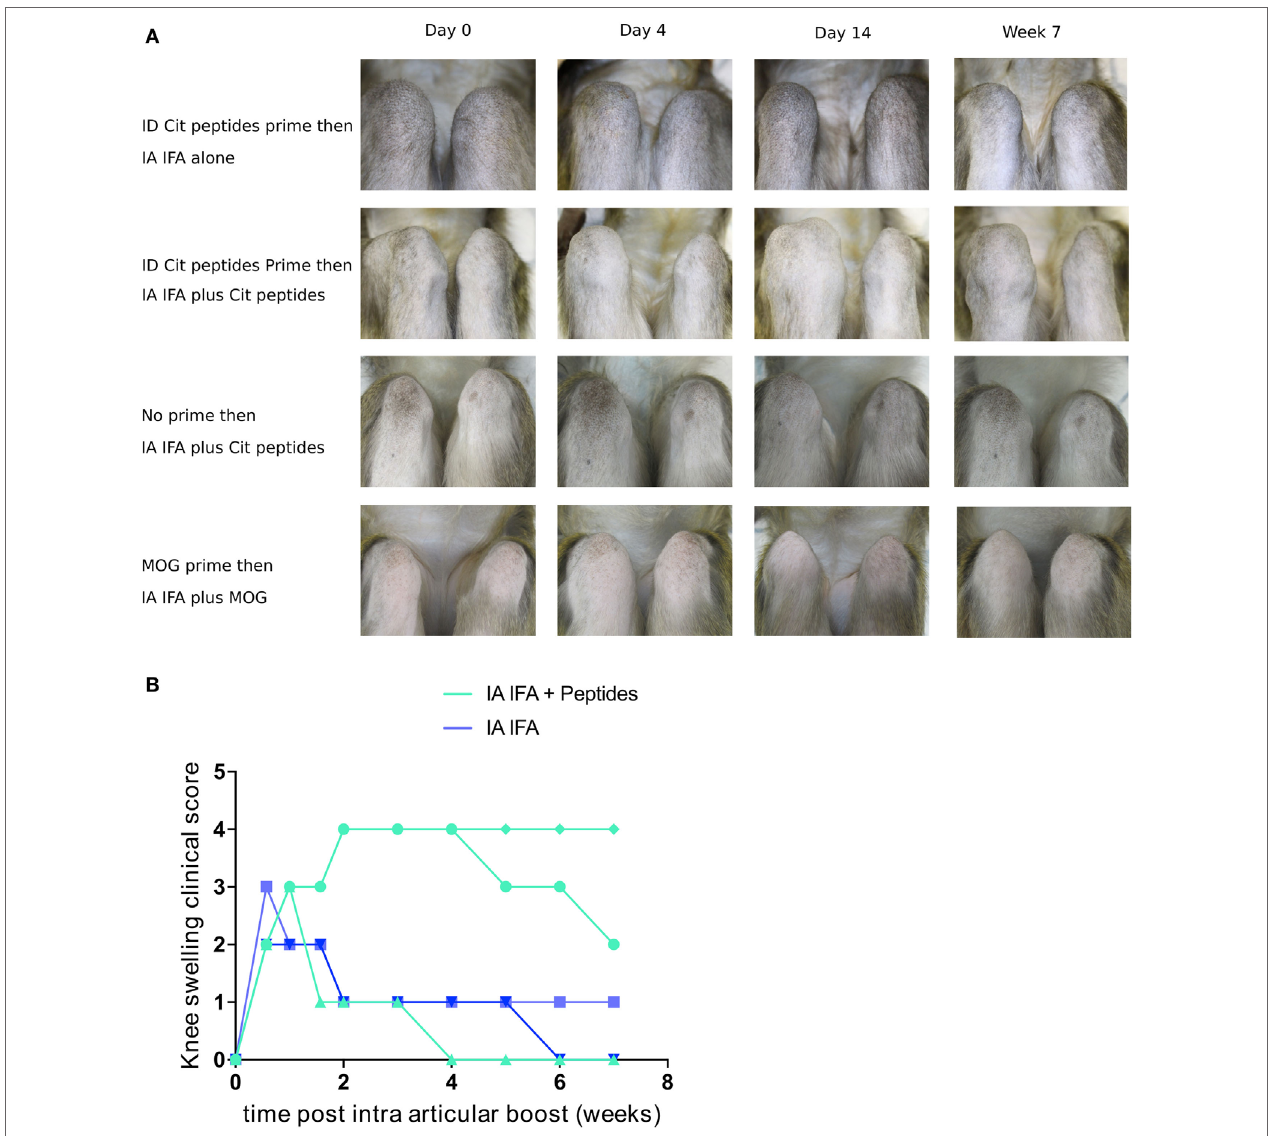
FigUre 3 | IA boost with citrullinated peptides leads to prolonged articular swelling. (a) Animals previously immunized with citrullinated peptides were boosted with IFA alone or citrullinated peptides + IFA in the right knee (upper two panels). Other control groups were (1) naïve animals injected with citrullinated peptides + IFA and (2) rhMOG-primed animals boosted intra-articularly with rhMOG + IFA (lower two panels). Weekly clinical monitoring of both knees is summarized with key time points. Photographs show 90° flexed right knees on the left side of the pictures. (B) Semi-quantitative longitudinal clinical evaluation of knee swelling for each animal with previous prime. Comparison between IFA alone and IA with citrullinated peptides + IFA. IFA, incomplete Freund’s adjuvant; IA, intra-articular; cit, citrullinated; rhMOG, recombinant human myelin oligodendrocyte